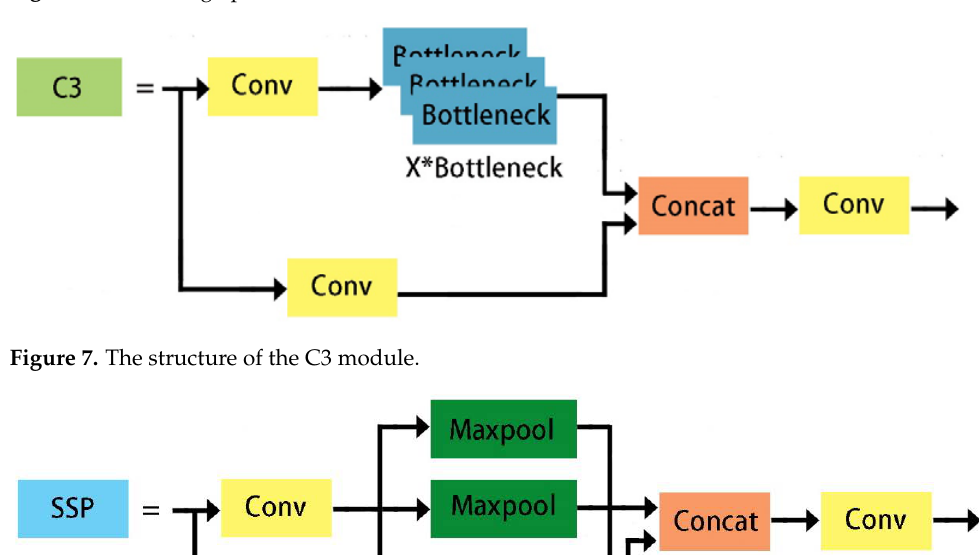
Figure 6. The slicing operation of the Focus module.